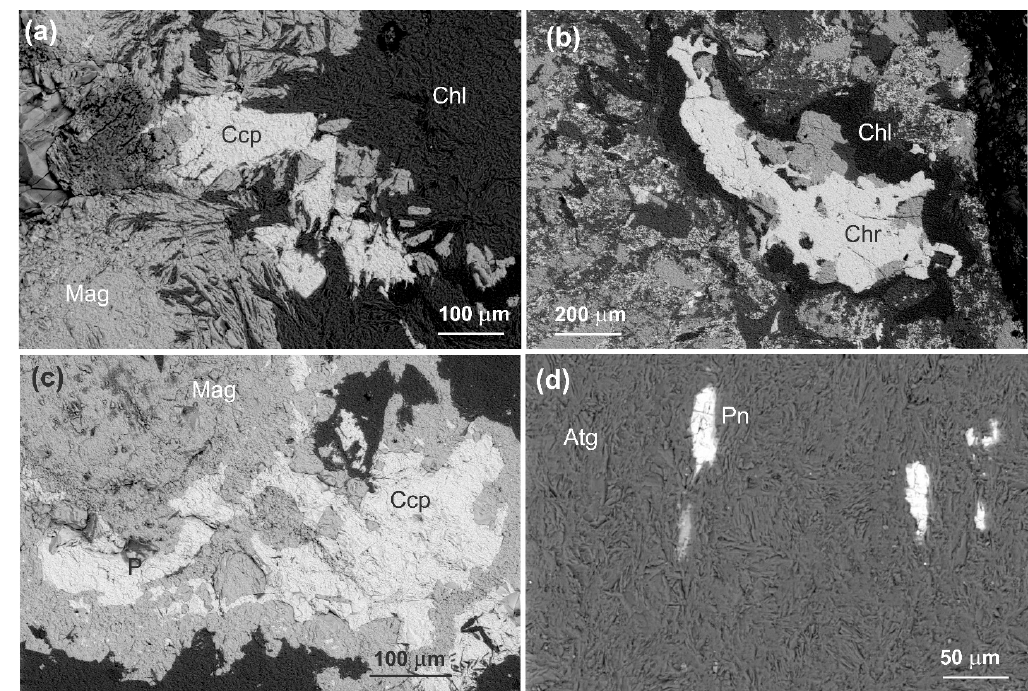
Figure 18. Microstructures in ore sample Brg1828 from Alp Tgavretga ( a – c ). SEM-BSE images. ( a ) chalcopyrite (Ccp, bright), magnetite (Mag, grey) and chlorite (Chl, dark). ( b ) Chromite (Chr) surrounded by chlorite (Chl). ( c ) chalcopyrite (Ccp, bright) and pyrite(P) transforming to magnetite (Mag, grey). ( d ) Serpentinite Brg1800 from Blaunca / Plaun dal Sel with pentlandite (Pn) in a matrix of antigorite